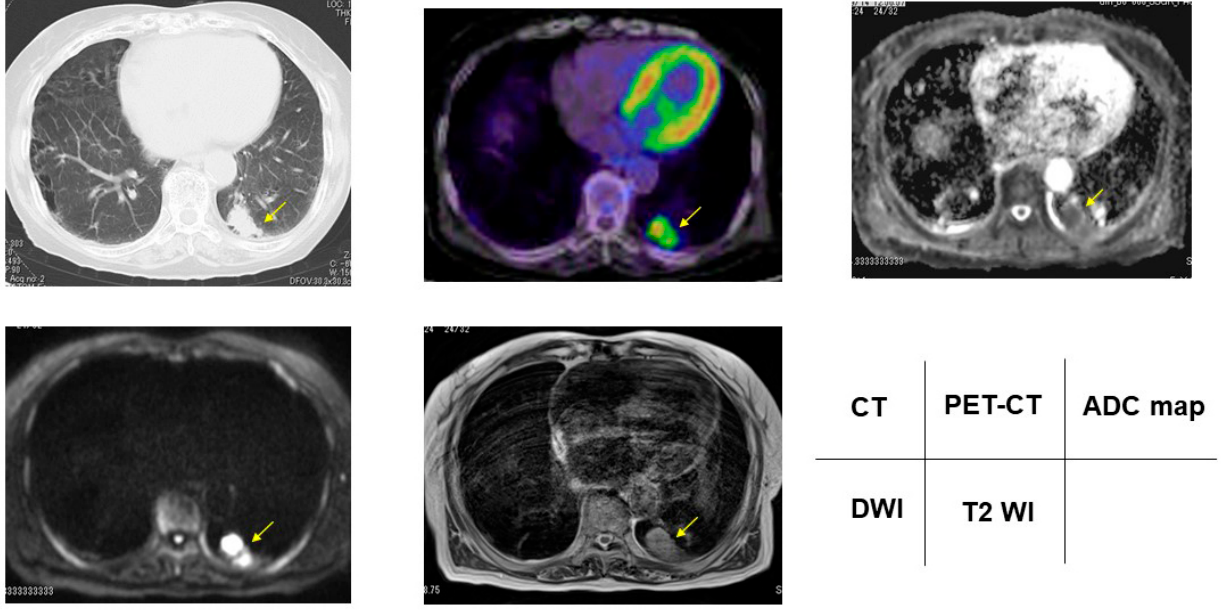
Figure 6. Papillary adenocarcinoma showed 7.7 for SUVmax, DDS 5, 1.20 × 10 − 3 mm 2 /s for ADC, and 1.98 for T2 CR. Yellow arrows shows PNMs.